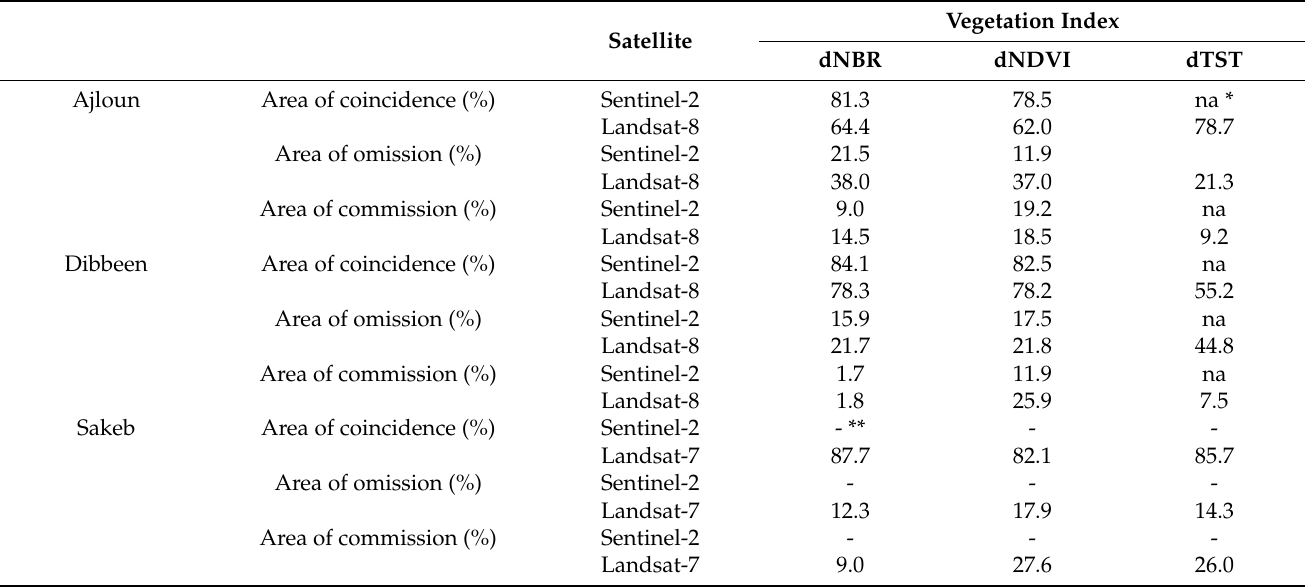
Table 2. Fire perimeter assessment (coincidence, omission and commission) of Landsat and Sentinel-2 differenced Normalized Burn Ratio (dNBR), Normalized Different Vegetation Index (dNDVI) and thermal surface temperature (dTST) for Ajloun, Dibbeen and Sakeb wildfires. Vegetation Index Satellite